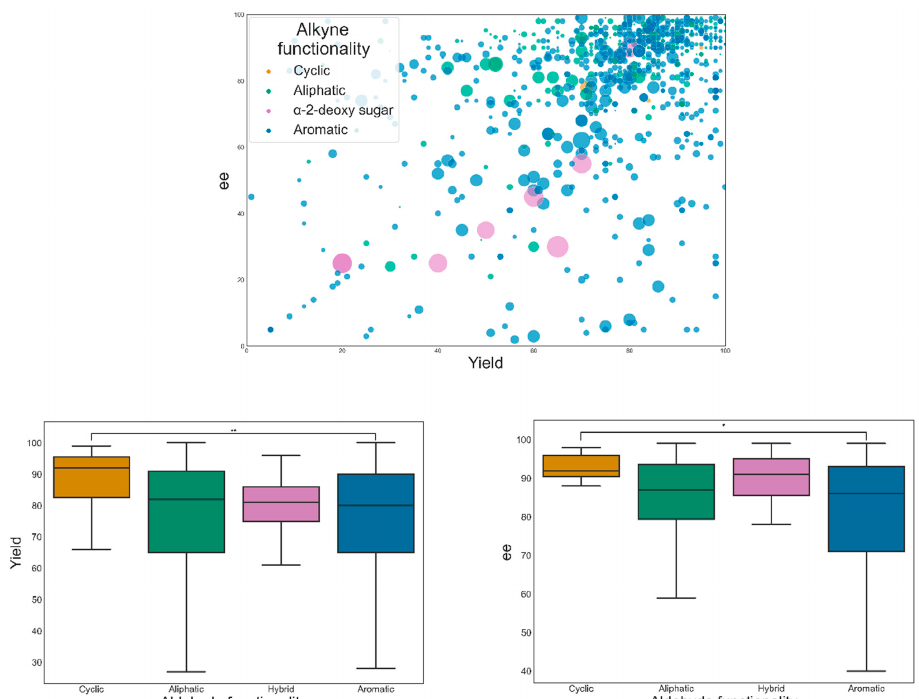
Figure 14. ( upper ) Distribution of aldehydes with enantioselectivites greater than 0. ( lower , left ) Yield of aldehydes with different functionalities. Statistical analysis performed using Student’s t -test ( p = 0.0045); ( lower , right ) ee of aldehydes with different functionalities. Statistical analysis performed using Student’s t -test ( p = 0.015). Symbol Meaning: * p ≤ 0.05, ** p ≤ 0.01 (For the last two choices only).